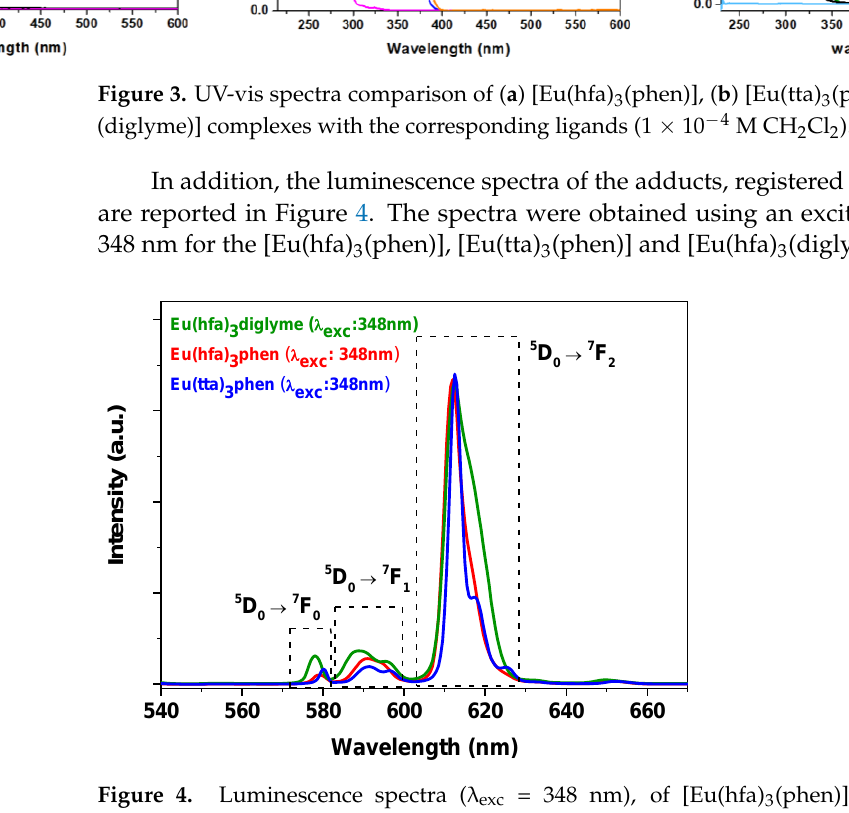
Figure 4. L uminescence spectra (λ exc = 348 nm), of [Eu(hfa) 3 (phen)], [Eu(tta) 3 (phen)] and [Eu(hfa) 3 (diglyme)], complexes in CH 2 Cl 2 .